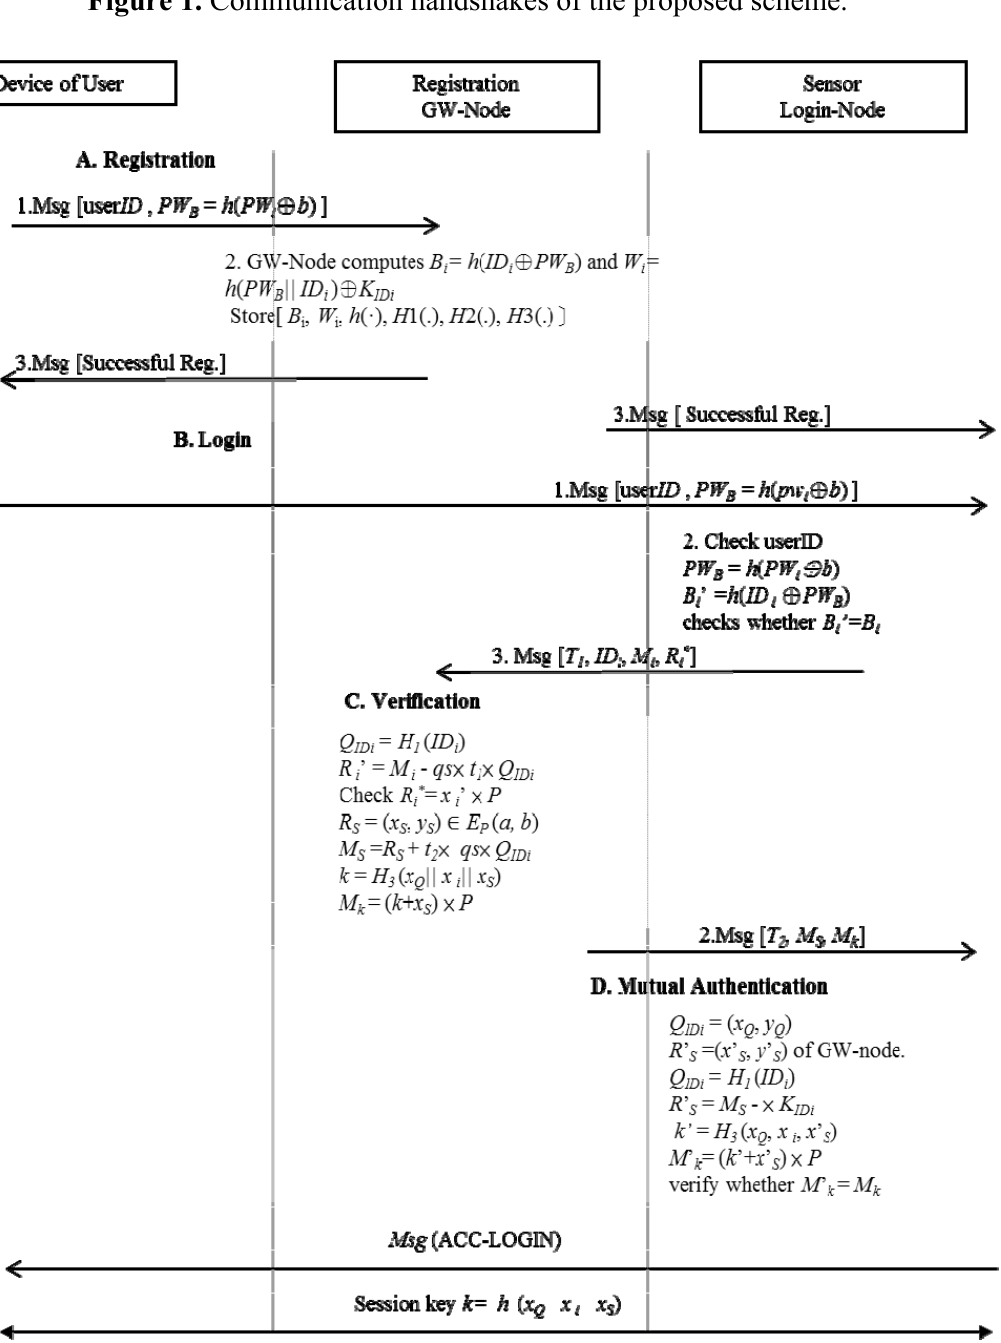
Figure 1. Communication handshakes of the proposed